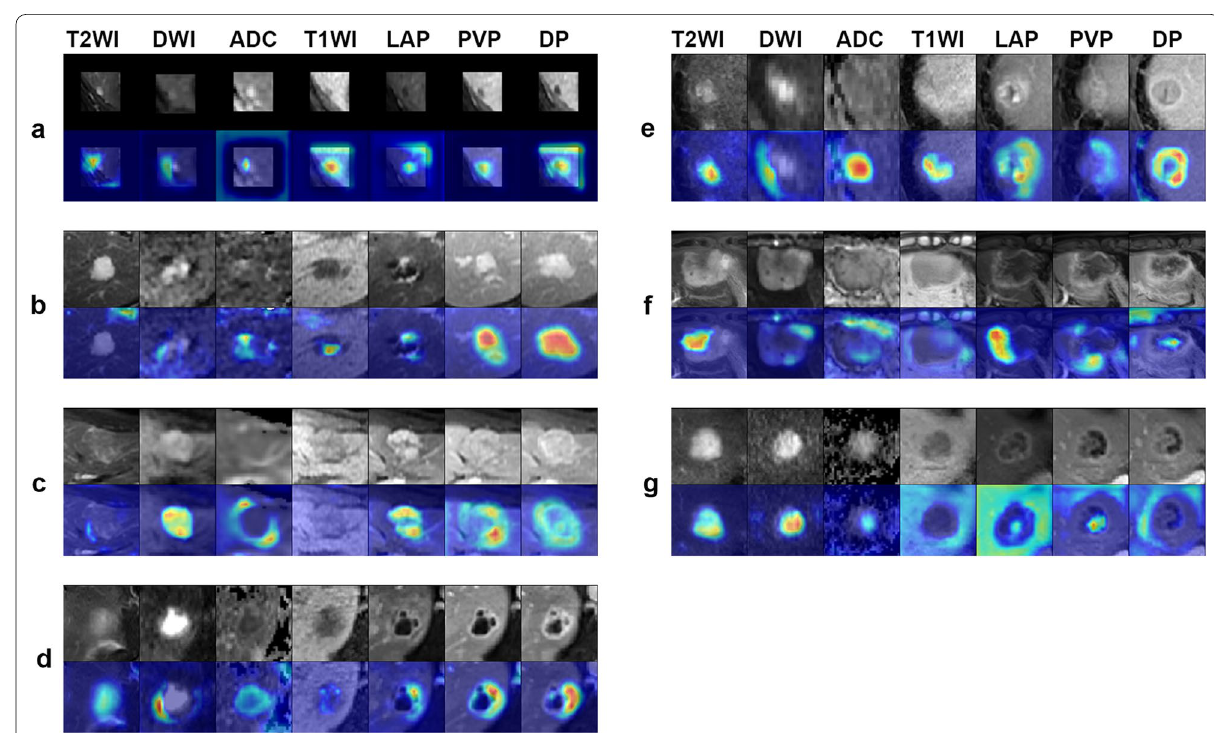
Fig. 5 Saliency map for example images from 7 category classifications of the test set. Red highlights the activation region of the radiologic imaging feature more associated with the predicted class. ( a ) Cyst, ( b ) HEM, ( c ) FNH, ( d ) HEP, ( e ) HCC, ( f ) ICC and ( g ) MET gain good display, and these maps reveal some typical radiologic imaging features of different